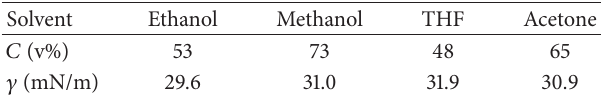
Table 3: The lowest concentration of solvents solution in which 𝜃 = 0 and their surface